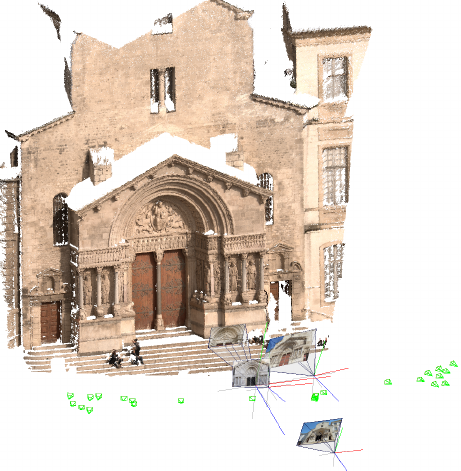
Figure 8: Spatial-orientation of web-based archives on Portal dataset